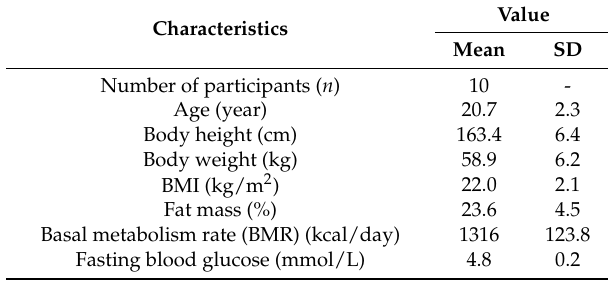
Table 2. Subject baseline characteristics (Mean values with their standard deviations (SD), n = 10).